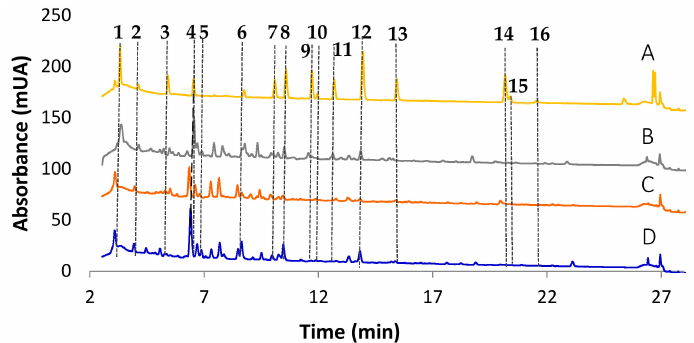
Figure 1. Chromatograms recorded at 280 nm using the proposed HPLC-UV/vis method. ( A ) Standard solution at 5 mg L − 1 ; ( B ) Ros é wine composed of Pinot Noir, Trepat and black Garnacha varieties